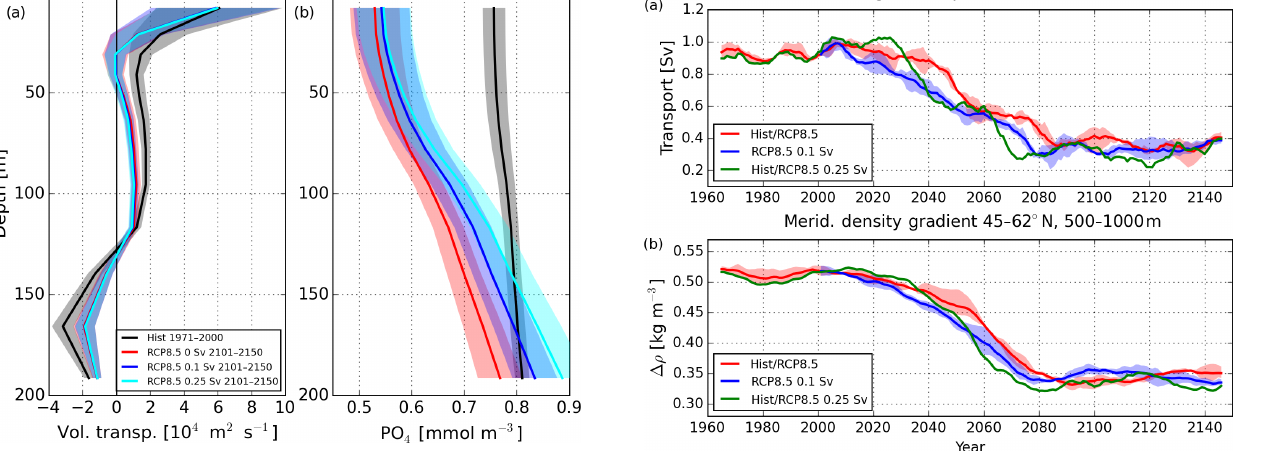
Figure 8. Profile of cross-shelf break transport (positive on-shelf, negative off-shelf) during winter (DJFM) integrated along the 200m isobath from 47 to 61.5 ◦ N (a) . Corresponding profile of mean phos- phate concentration (b) . Solid: ensemble means of historical condi- tions (1971–2000, black) and RCP8.5 conditions (2101–2150) for experiments E0 (red) and E010 (blue), as well as a single realization of E025 (cyan). Shaded areas: ensemble means of standard devia- tion (and standard deviation of E025).